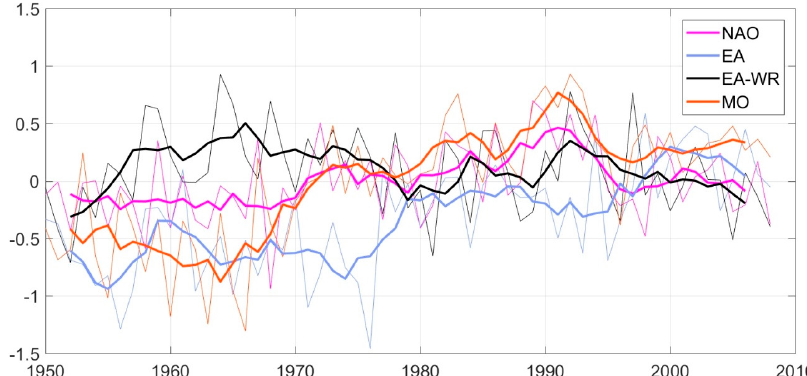
Figure 6. Time series of the yearly (dashed lines) and decadal (5-year running means, solid lines) variability of the main climatic indices over the Mediterranean region. Notice that the interannual variability is of more interest than the value itself.